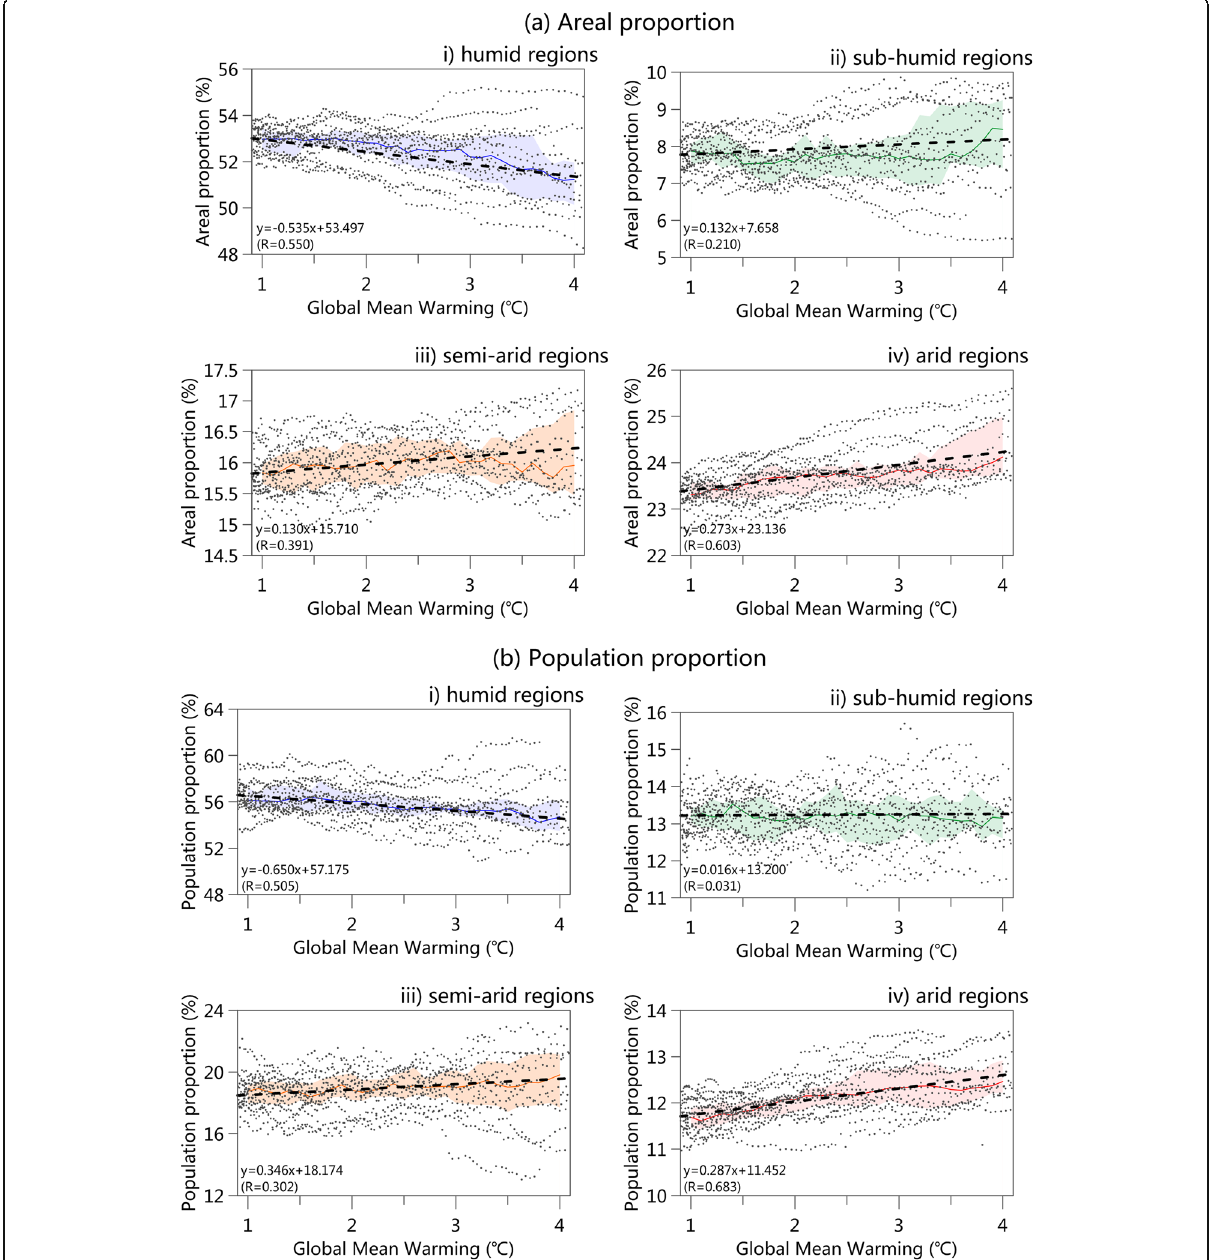
Fig. 6 Areal and population proportion of arid/humid regions as a function of warming level over Asia. Areal proportion ( a ) and population proportion ( b ) of humid, sub-humid, semi-arid, and arid regions as a function of warming level over Asia. The dashed lines are the linear trends, while the regression equation and the Pearson ’ s correlation coefficient are labelled on the bottom-left of each subplots. The solid lines and shaded areas indicate multi-model medians and interquartile ranges, respectively. The population proportions at the different warming levels were estimated from the 2100 population projection under the SSP2